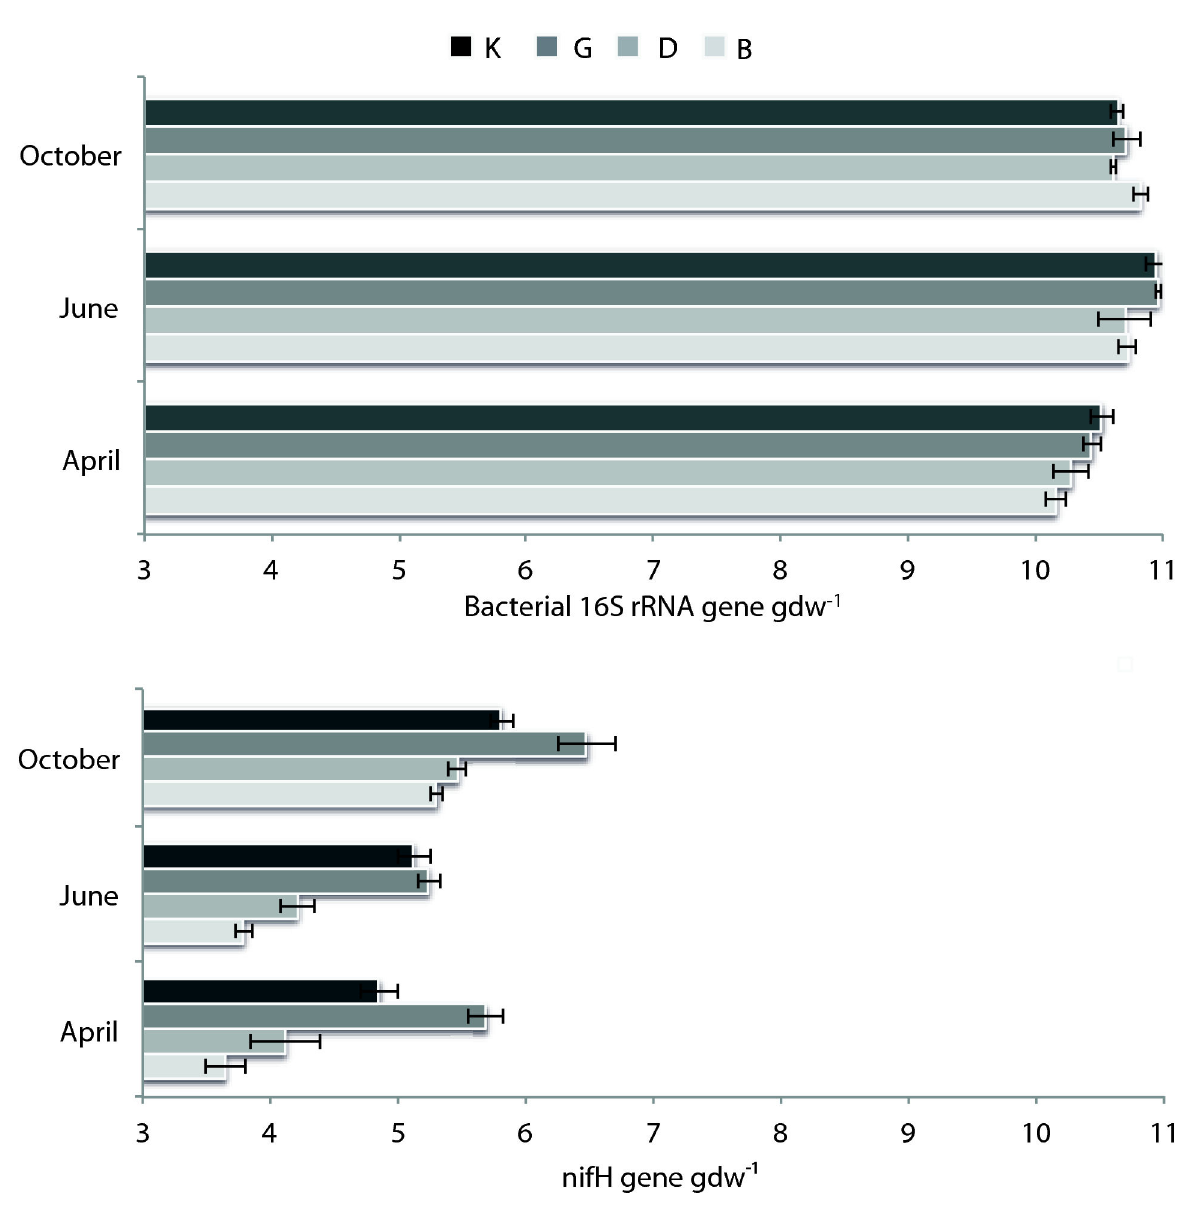
Figure 1. Changes in abundance of bacterial 16S rRNA and nif H genes. Soils B, D, K and G were collected in April, June and October of 2010. The copy numbers per gram of dry soil was estimated by real-time PCR. Soils: B, Buinen; D, Droevendaal; K, Kollumerwaard and G,